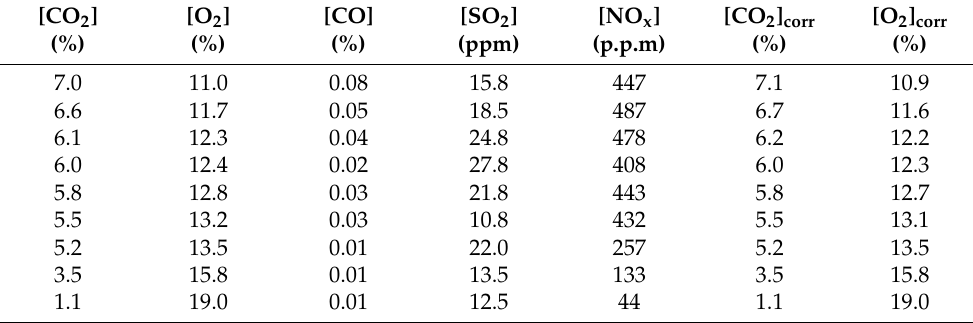
Table 3. Each data point is the average result of four measurements. Table 3. Concentrations of locomotive flue gas components